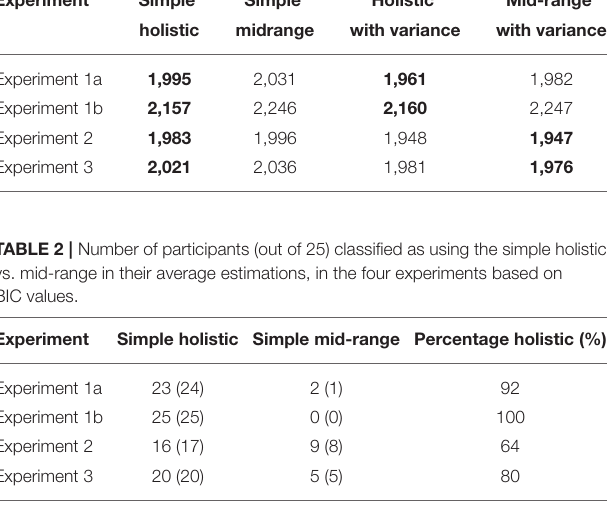
TABLE 3 | Number of participants (out of 25) classified as using the complex holistic vs. mid-range in their average estimations, in the four experiments based on BIC